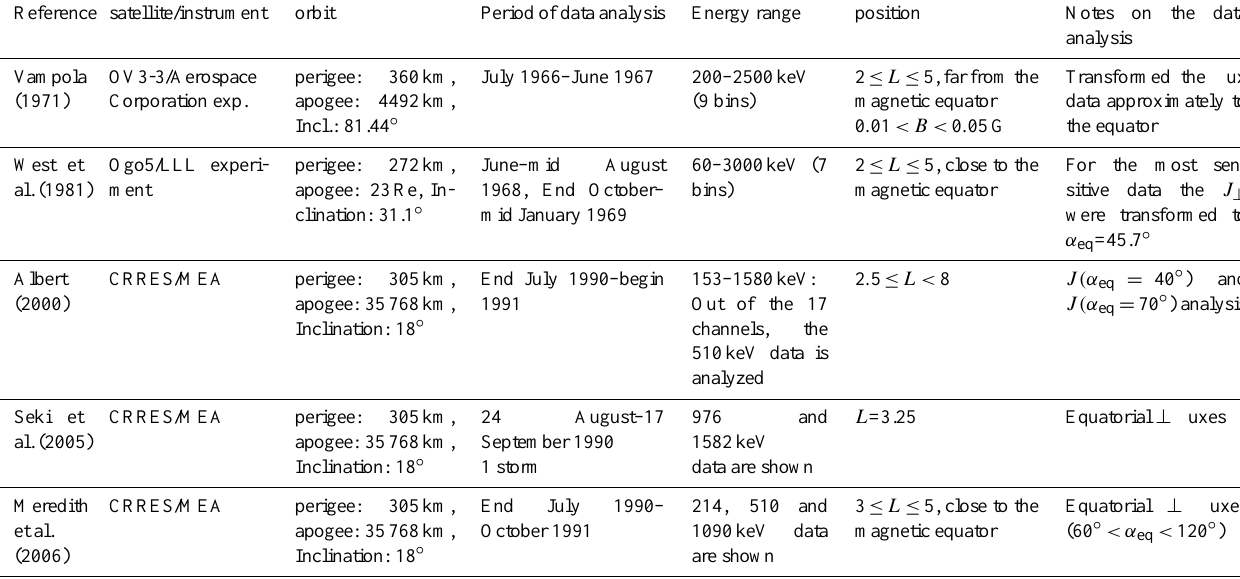
Reference satellite/instrument orbit Period of data analysis Energy range